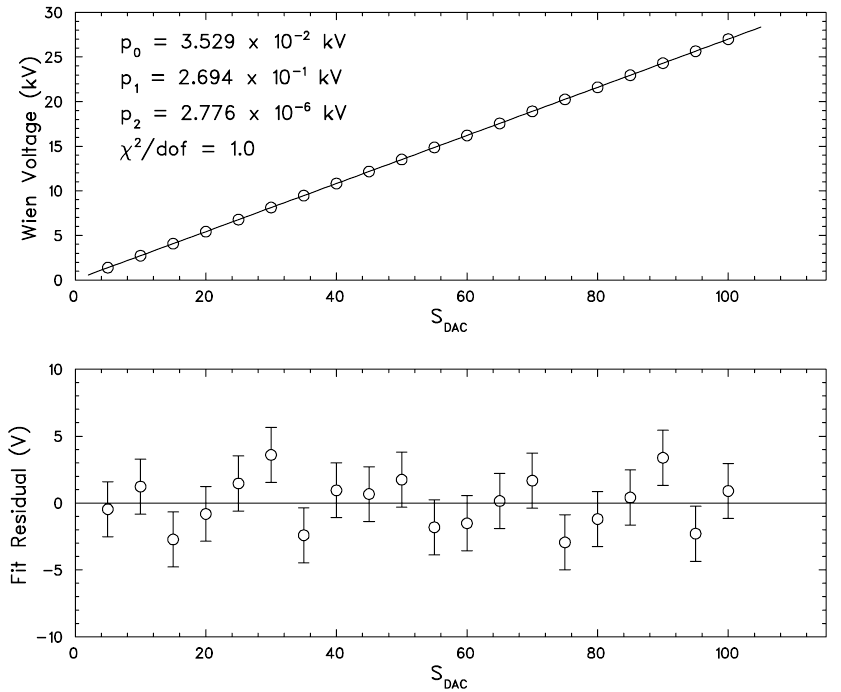
FIG. 7. Wien voltage with second-order polynomial fit (upper panel) and fit residuals (lower panel) both shown as a function of the ). DAC set point ( S dac